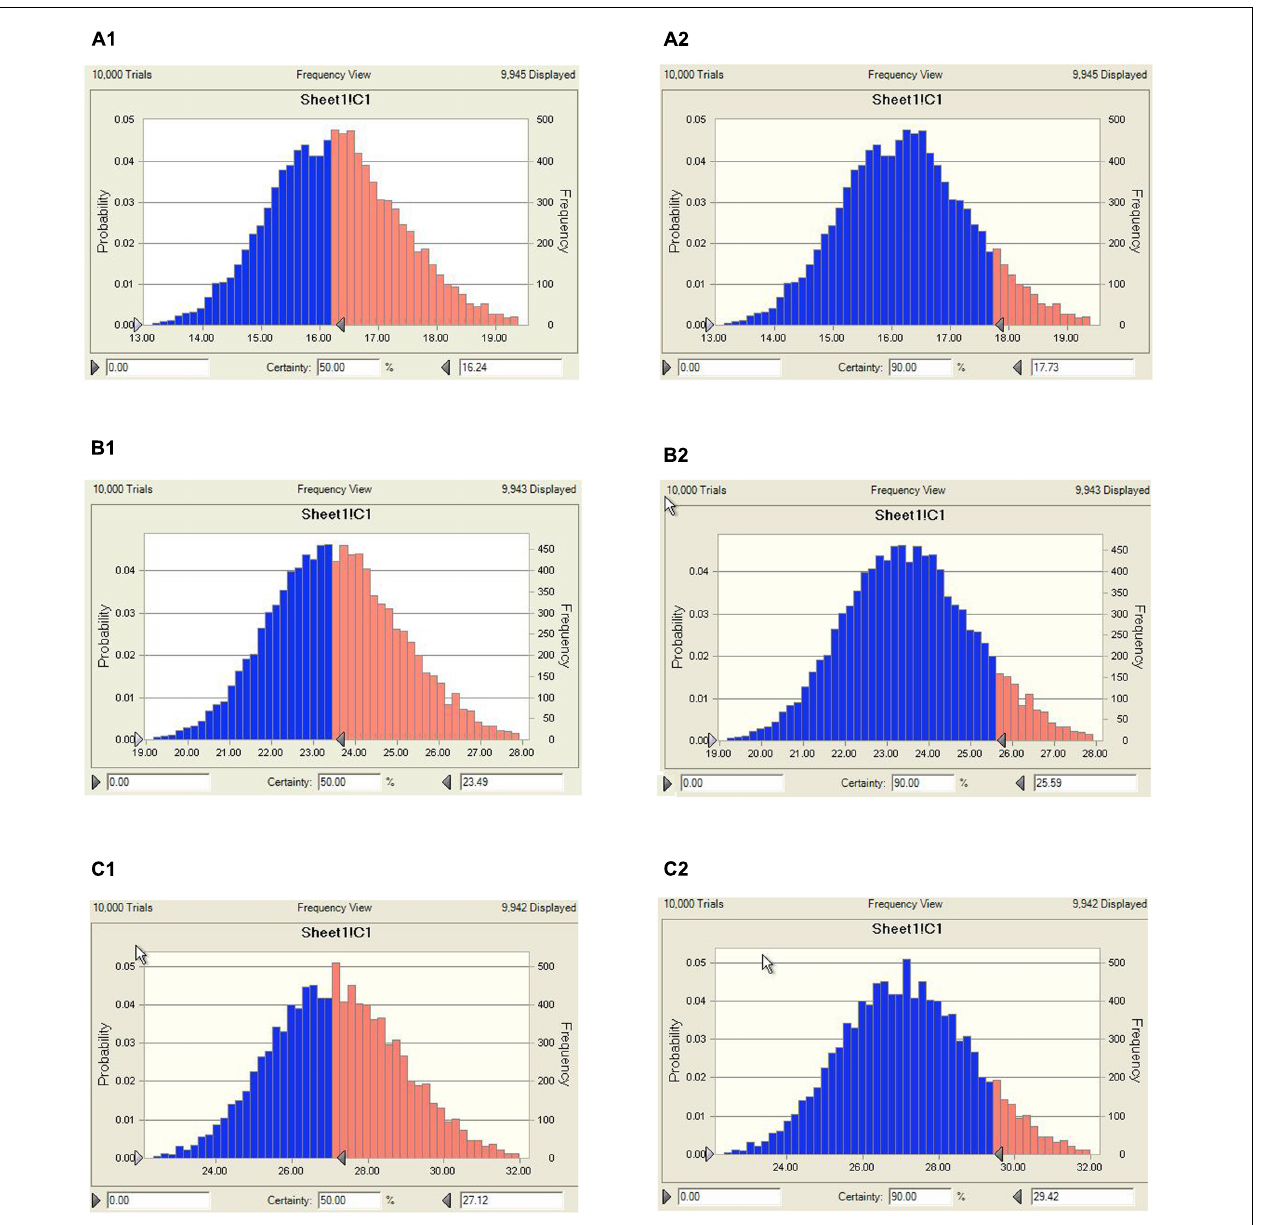
FIGURE 7 | Distribution of predicted population doses (AUC 0 − 24h /MIC) of MBF against E. coli (HB197). (A 1 ) Presented the predicted population dose for bacteriostatic at 50% target, (A 2 ) presented the predicted population dose for bacteriostatic at 90% target, (B 1 ) presented the predicted population dose for bactericidal at 50% target, (B 2 ) presented the predicted population dose for bactericidal at 90%, (C 1 ) presented the predicted population dose for elimination at 50% target, (C 2 ) presented the predicted population dose for elimination at